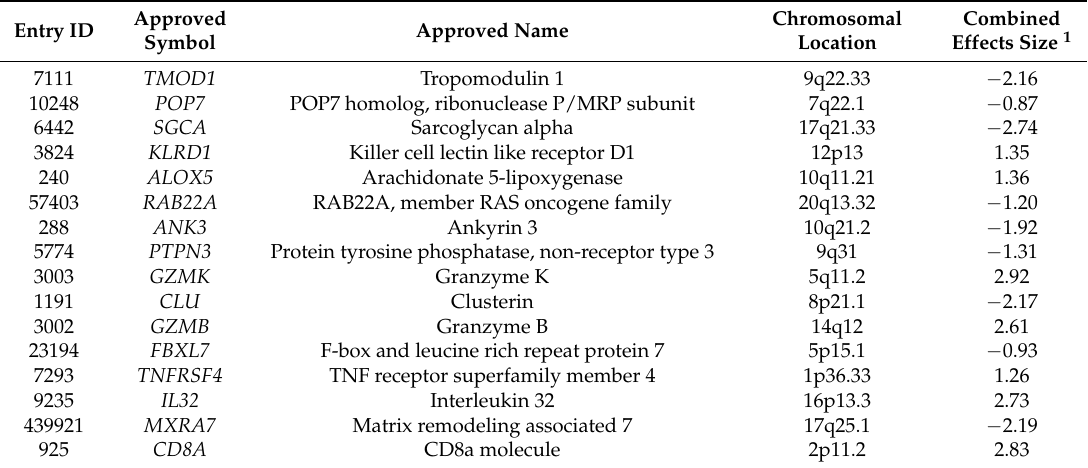
Figure 1. Workflow of variable selection and machine learning classification. ( a ) Variable selection workflow. ( b ) Classification analysis workflow. RF: random forests; SVM: support vector machines; kNN: k nearest neighbors. GSE55457, GSE55584, and GSE55235 are from the same study and were used for modeling and validation of the data-driven proposed biomarkers. Table 1. The 16-gene signature derived from AUC-RF based variable selection